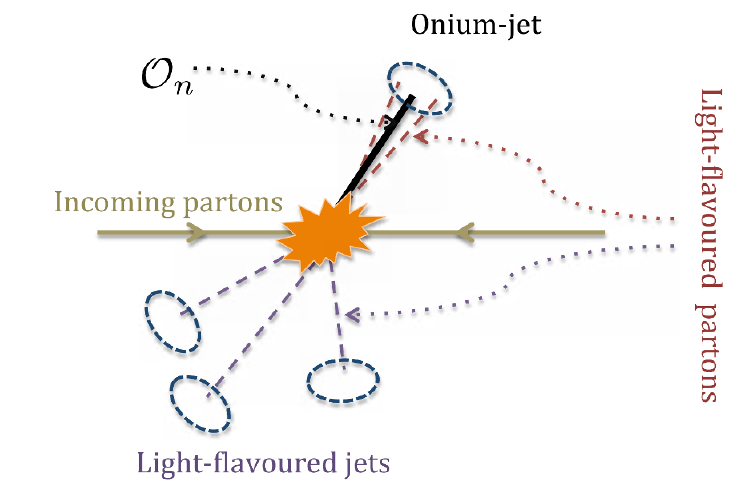
Figure 4 . Schematic depiction of inclusive quarkonium